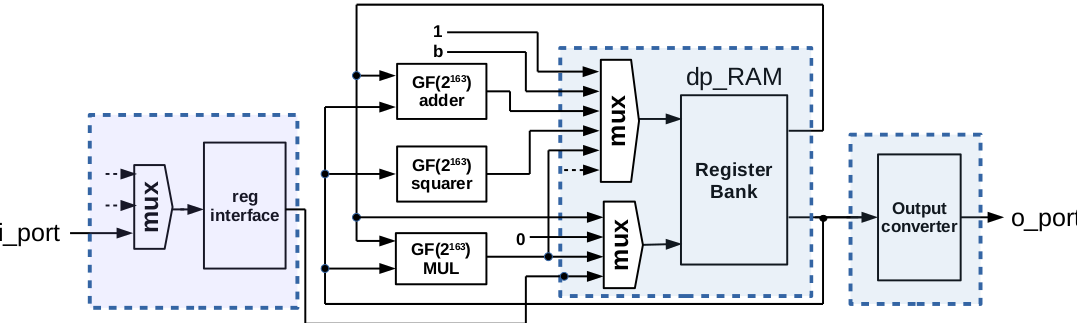
Figure 8. Blocks providing ECC-163 support in the ECC163AES128